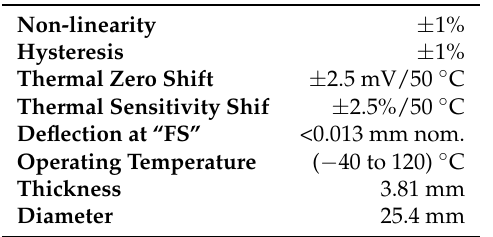
Table 1. Main technical specifications of the compression load